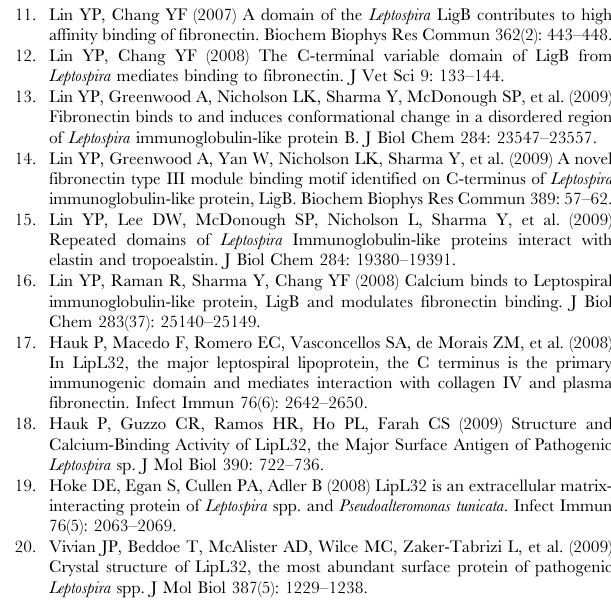
Figure S1 W1073C mutation cannot affect the structure of LigBCen2R. Far-UV CD analysis of LigBCen2R and LigB- Cen2R. The molar ellipticity, W , was measured from 190 to 250 nm for 10 m M of each protein in Tris buffer with 100 m M of calcium chloride. Figure S2 Representative SECMALLS analysis of the molar ratio of LigBCen7’-8-GBD complex. The data traces of SEC- MALLS from the instrument’s three in-line detectors, measuring the refractive index, light scattering, and UV absorbance (280nm), are shown in arbitrary unit. Molecular weight was determined for the major species using the data within the shaded area. Shaded area 1, 2, and 3 indicate LigBCen7’-8-GBD complex, GBD, and LigBCen7’-8, respectively. The result of molar ratio was shown on Table 4. Table S1 The sources of clones used in this